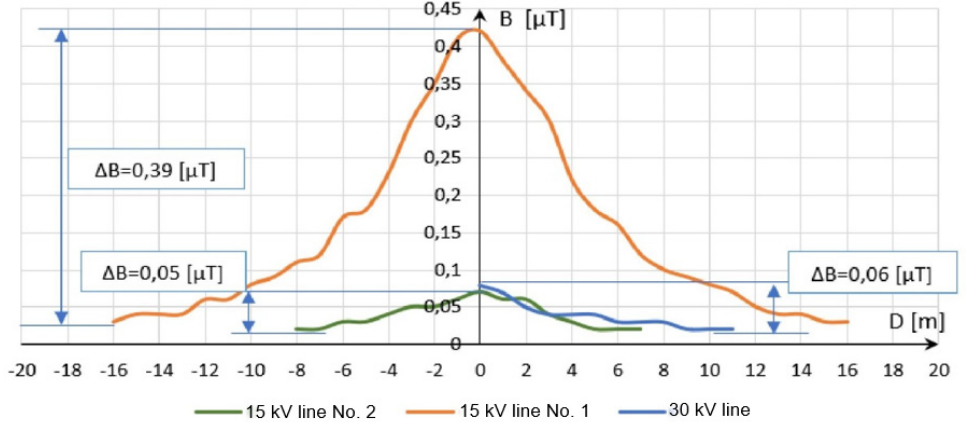
Figure 3. Distribution of magnetic field induction B across the line, for measuring point No. 1 and the ELF frequency range (induction measuring methodology as in Figure 2).